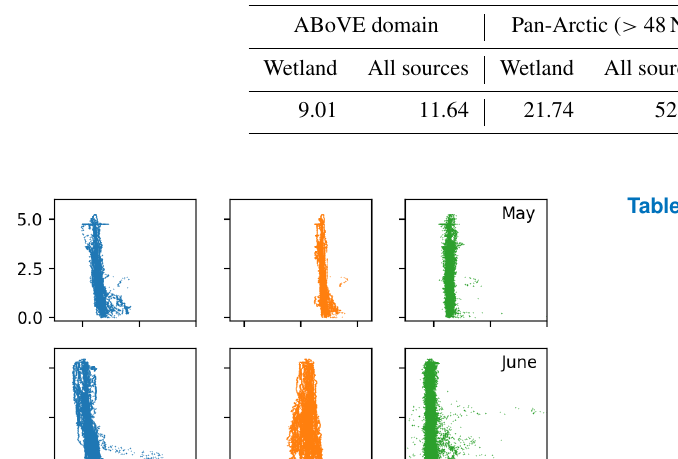
Table 3. GEOS CH 4 flux estimates (TgCH 4 yr − 1 ) for 2017. CH 4 flux emissions are specified for (a) the wetland component and (b) all source components, which include wetlands, industrial and fossil fuel, agriculture and waste, biomass burning, biofuel burning, and other natural emissions.